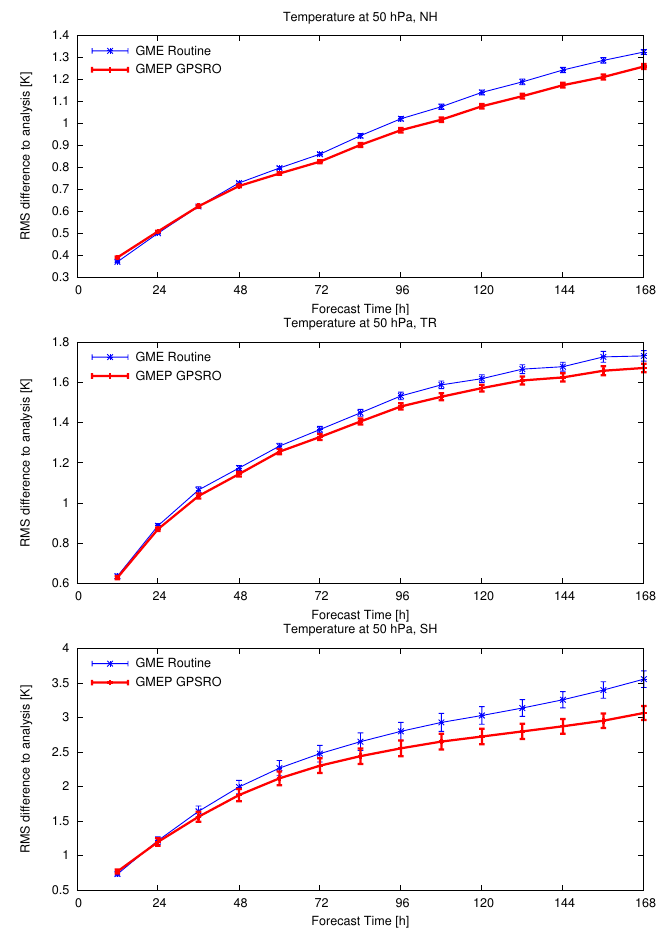
Fig. 4. The RMS difference of the 50hPa temperature as a function of forecast time in the Northern Hemisphere (top), Tropics (middle), and Southern Hemisphere (bottom) for the operational routine (thin blue line) and the experiment including GPSRO data from COSMIC, GRACE-A, and GRAS (thick red line). The statistics is based on 62 forecasts (00Z and 12Z) corresponding to 31days of data during July 2010. The error bars give a rough indication of the uncertainty of the mean as estimated from the time series of the RMS differences. The comparisons are performed against each experiment’s own